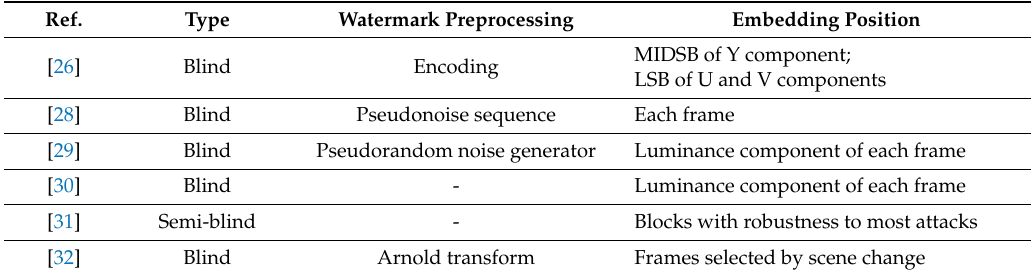
Table 2. Summary comparison of several watermarking algorithms in spatial domain.